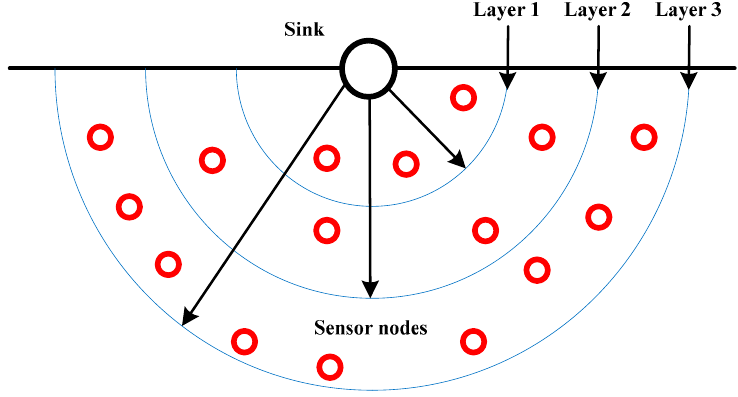
Figure 9. Layer assignment phase in APCR.